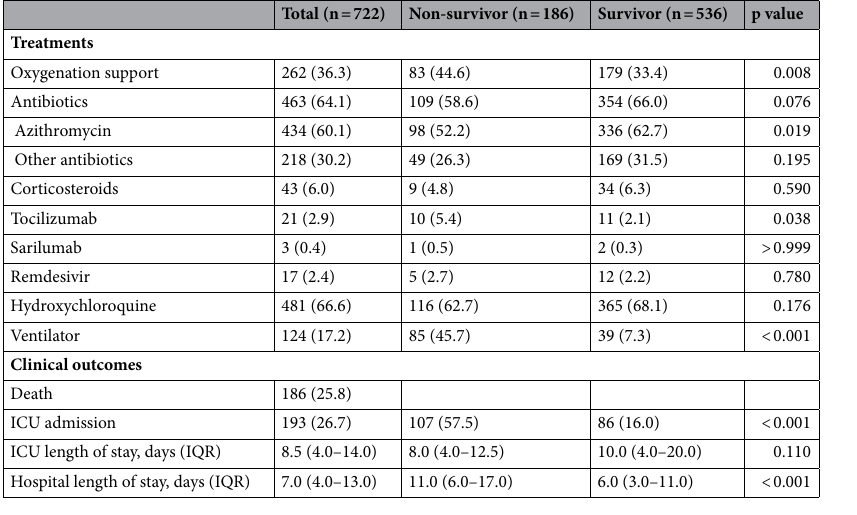
Table 2. Treatment received during hospitalization and clinical outcomes. Data are median (IQR) or n (%). p values were calculated by Mann–Whitney U test, χ 2 test, or Fisher’s exact test, as appropriate. ICU intensive care